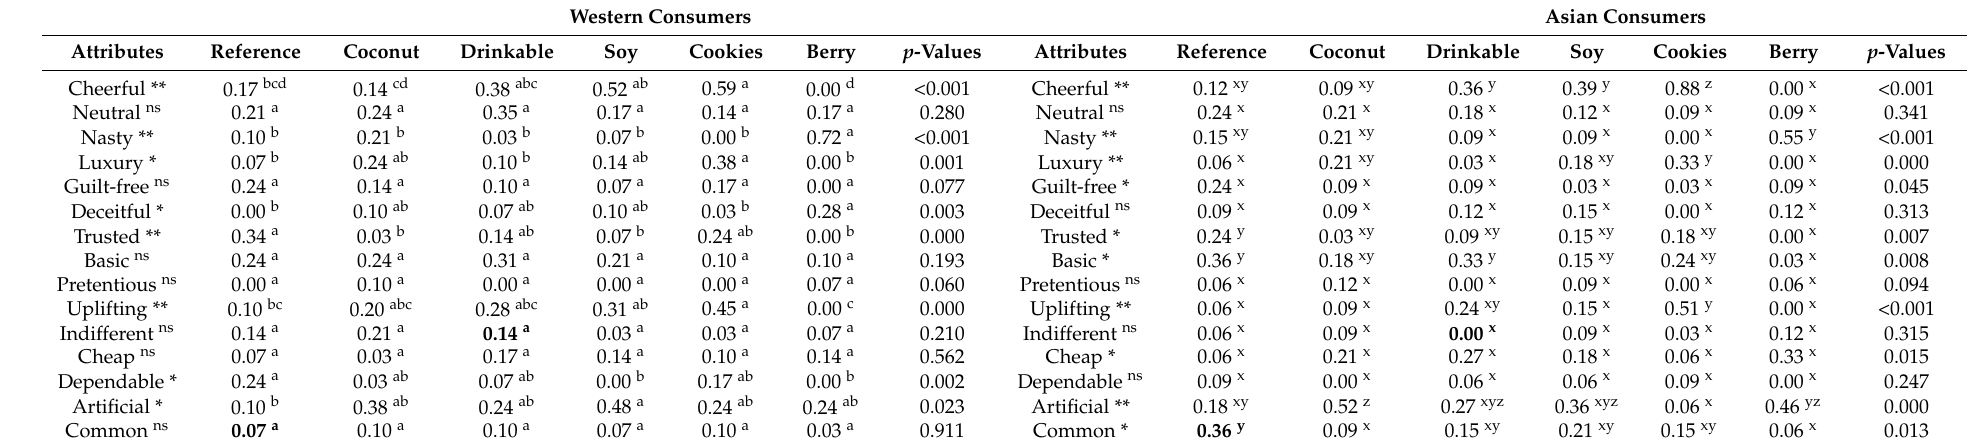
Table 2. Cochran’s Q test for emotion terms shown for the two cultural groups (Western consumers, Asian consumers) comparing terms within the culture, and using Fisher’s test to compare terms across